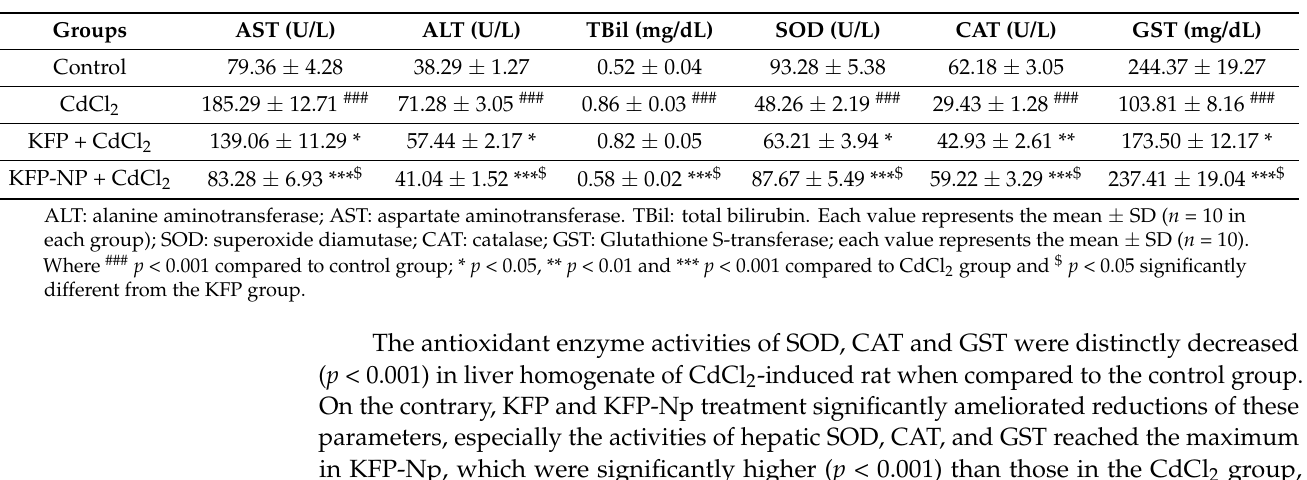
Table 4. Effect of KFP-NPs on serum liver function and antioxidant parameters in CdCl 2 intoxicated rat.